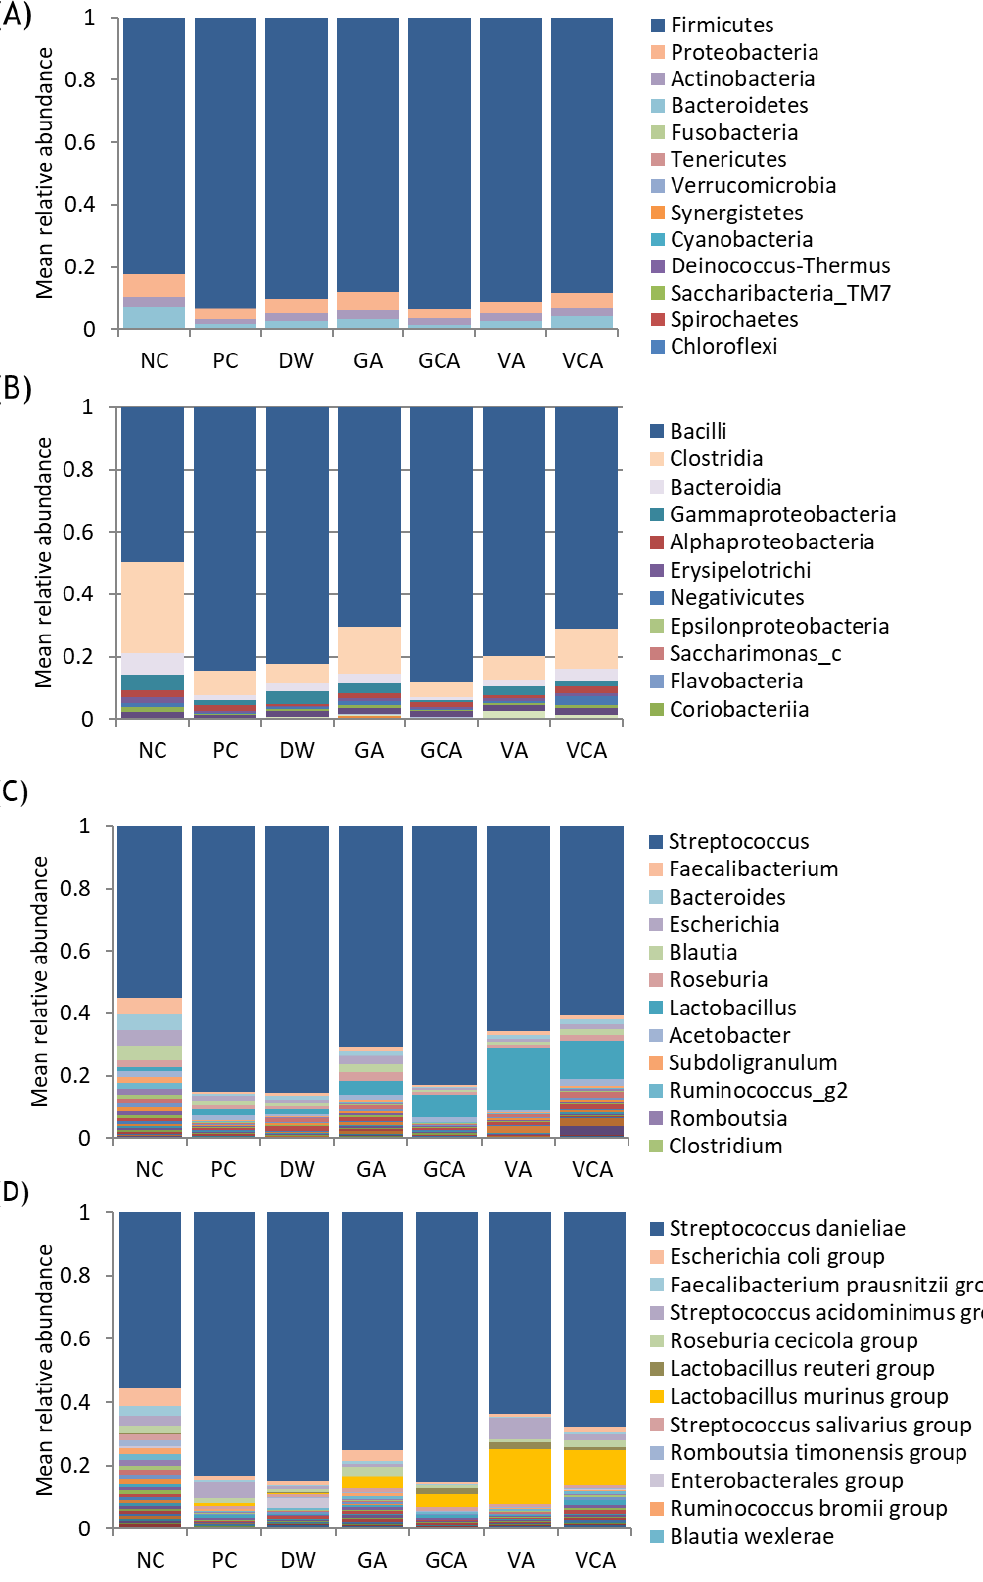
Figure 6. Bacterial community composition at the phylum ( A ), class ( B ), genus ( C ), and species levels ( D ). The mean relative abundance of each species detected in each sample is shown.